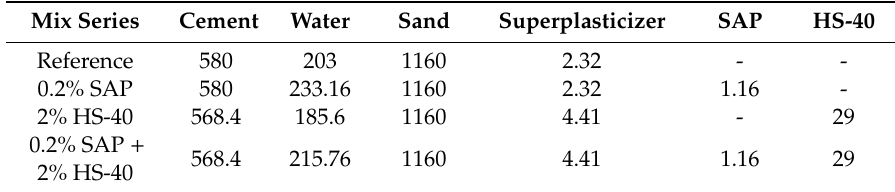
Table 1. Mix proportions in kg / m 3